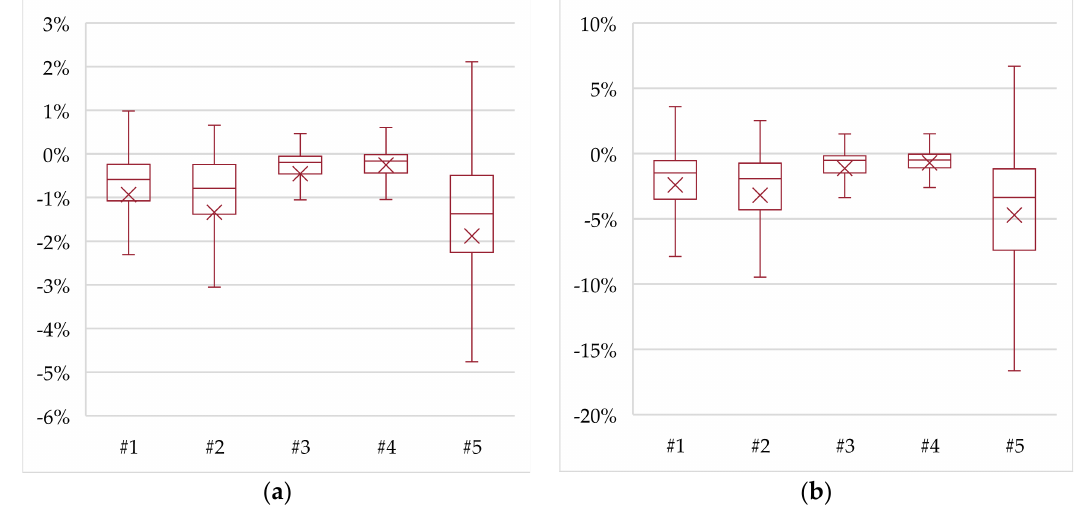
Figure 7. Resulted changes in ( a ) renewable energy use; ( b ) flexible loads.